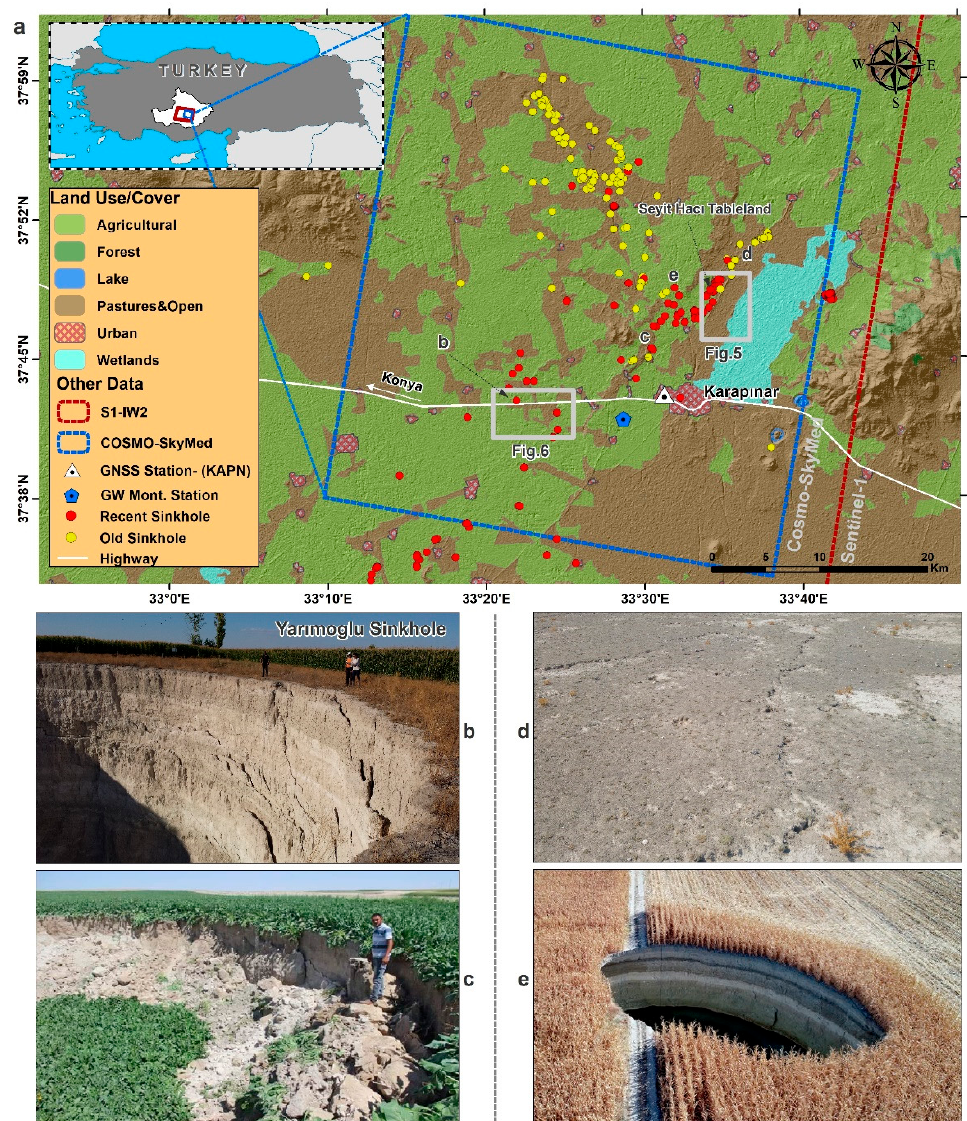
Figure 1. ( a ) Location of the study area on a Land Use/Land Cover map. Yellow and red circles mark the locations of old and recent sinkholes, respectively. Blue and Red frames show the footprints of the COSMO-SkyMed and Sentinel-1, respectively. Grey frames mark the locations of Figures 5 and 6. ( b ) Yar ı m o ğ lu Sinkhole. ( c ) A sinkhole formed in the beet field on 23 August 2016. ( d ) Some surface fissures. ( e ) A sinkhole formed in the cornfield in September 2018.